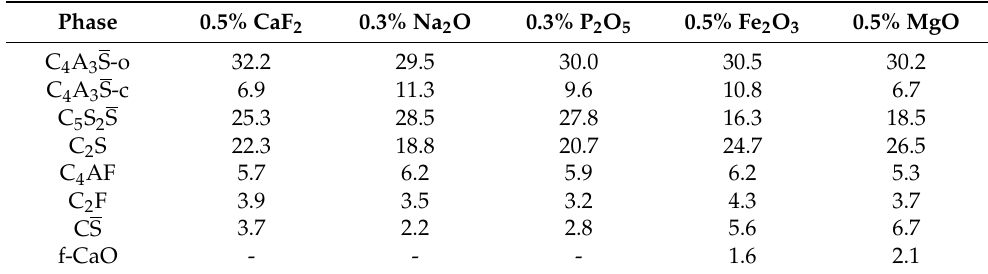
Table 5. Quantitative mineralogical compositions of doped cement clinker A